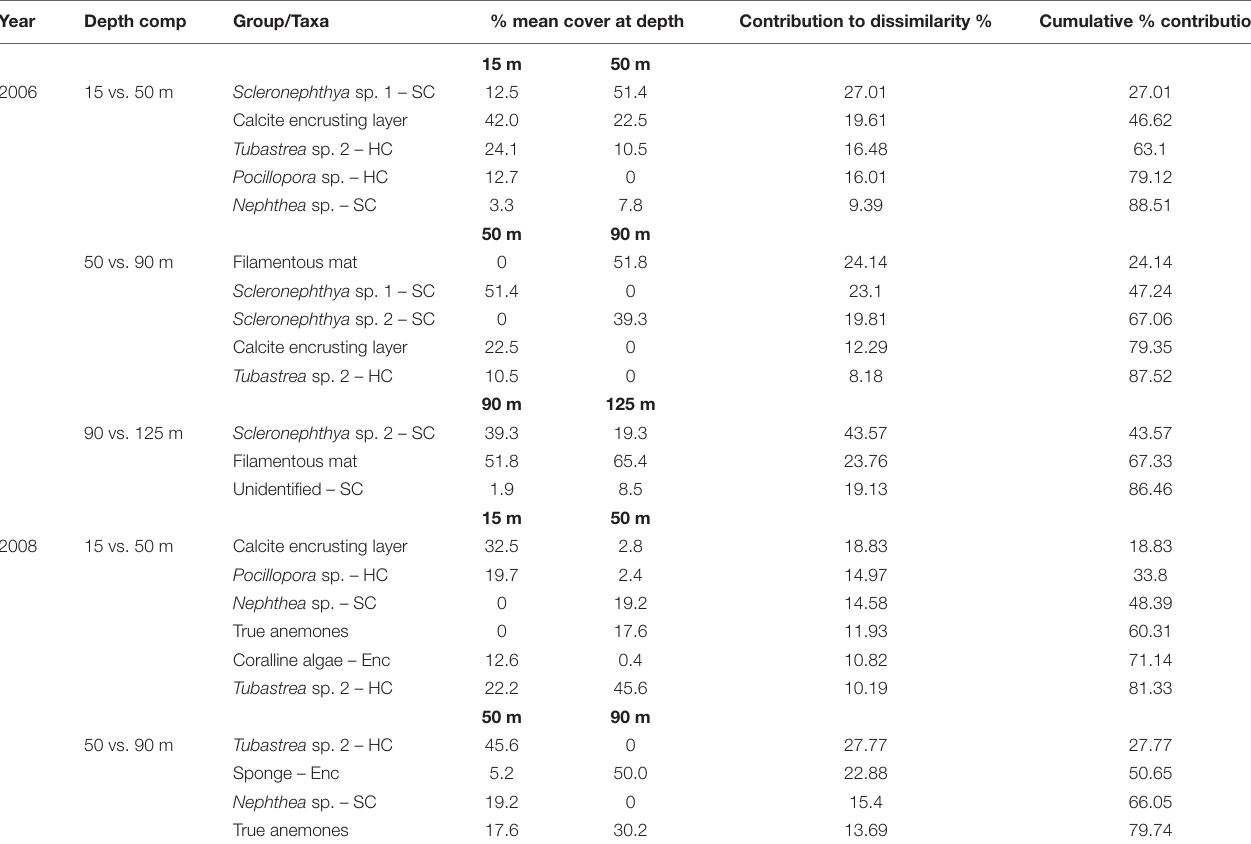
TABLE 2 | Percent mean cover and Similarity Percentage results (SIMPER) for sessile invertebrates contributing up to 80% of the dissimilarity in coverage between adjacent depths on the Goodwyn Alpha platform in 2006 and